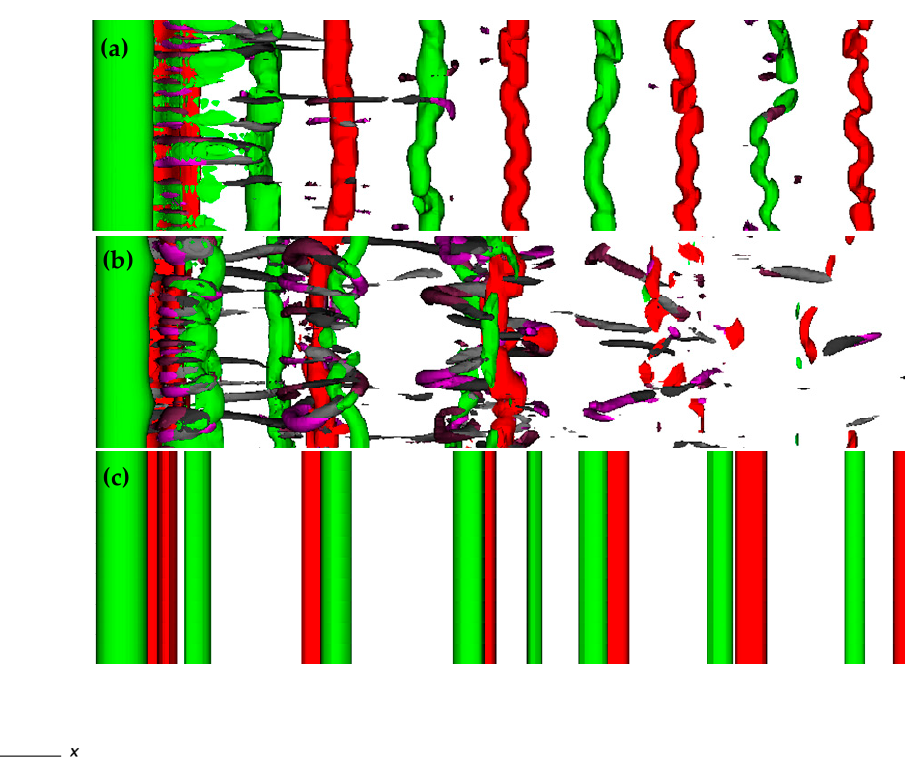
Figure 11. Counter-clockwise cylinder oscillation: Instantaneous isocontours of spanwise vorticity for the plane z = 3 for F = 0.9 and ( a ) A y /D = 0.20, ( b ) A y /D = 0.30, ( c ) A y /D = 0.60.